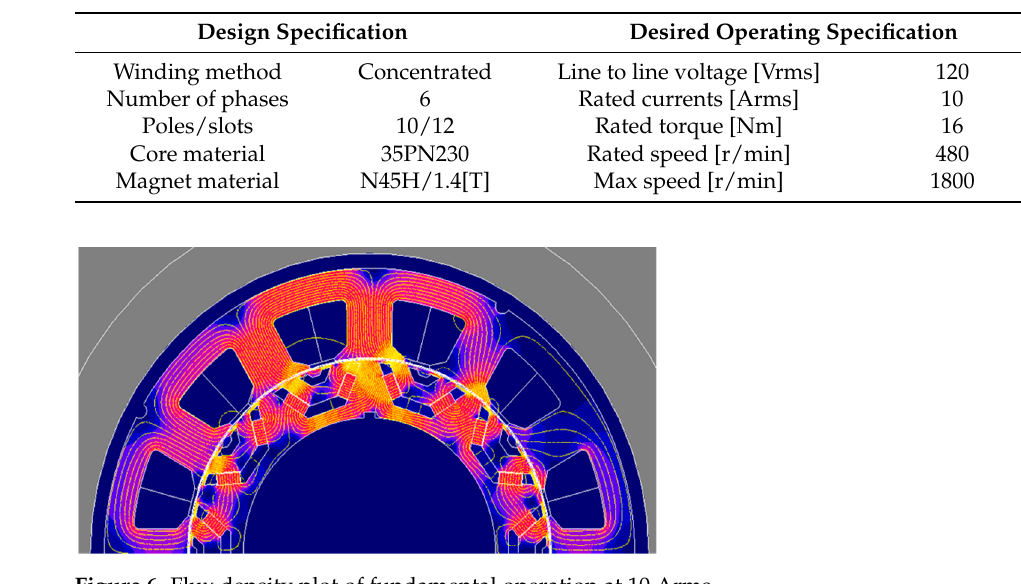
( b ) Figure 7. Torque and stator current calculations via FEM at 10 Arms: ( a ) torque; ( b ) phase current A.